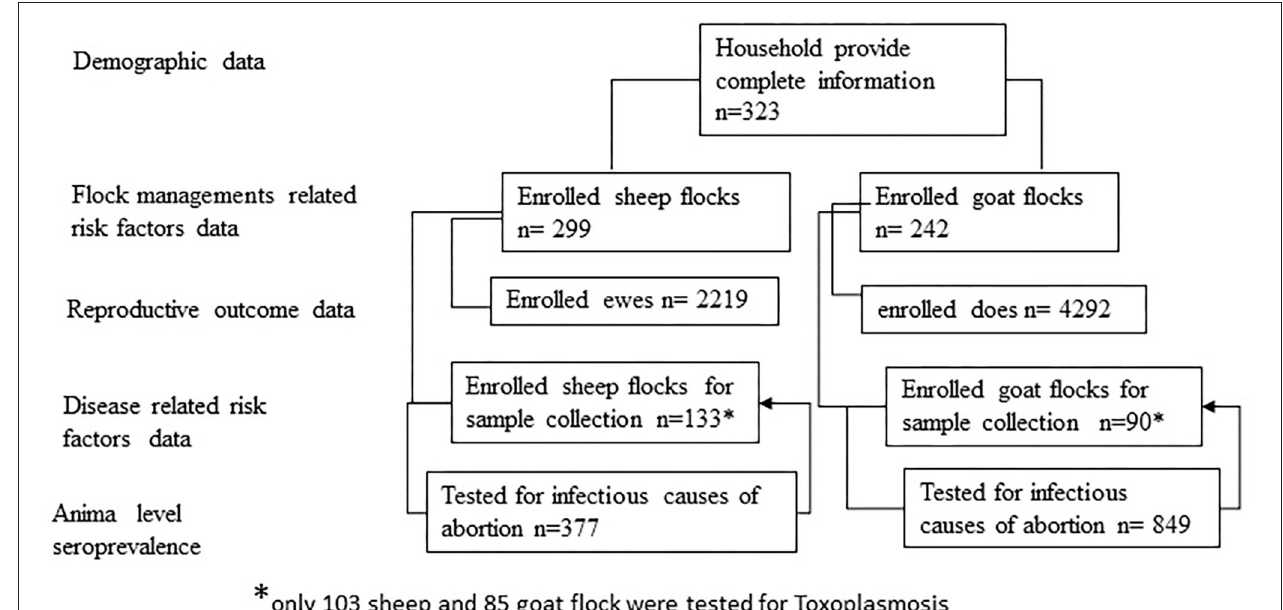
FIGURE 3 | Study subject enrolment flow diagram.